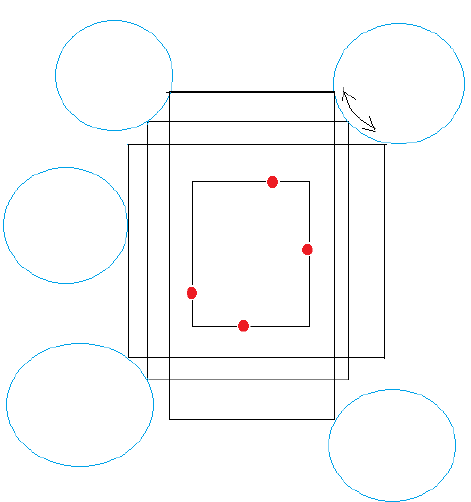
Figure 12. A circle bounding the rectangle at a corner allows the corner to slide along the arc. Each position of the corner uniquely determines its two adjacent